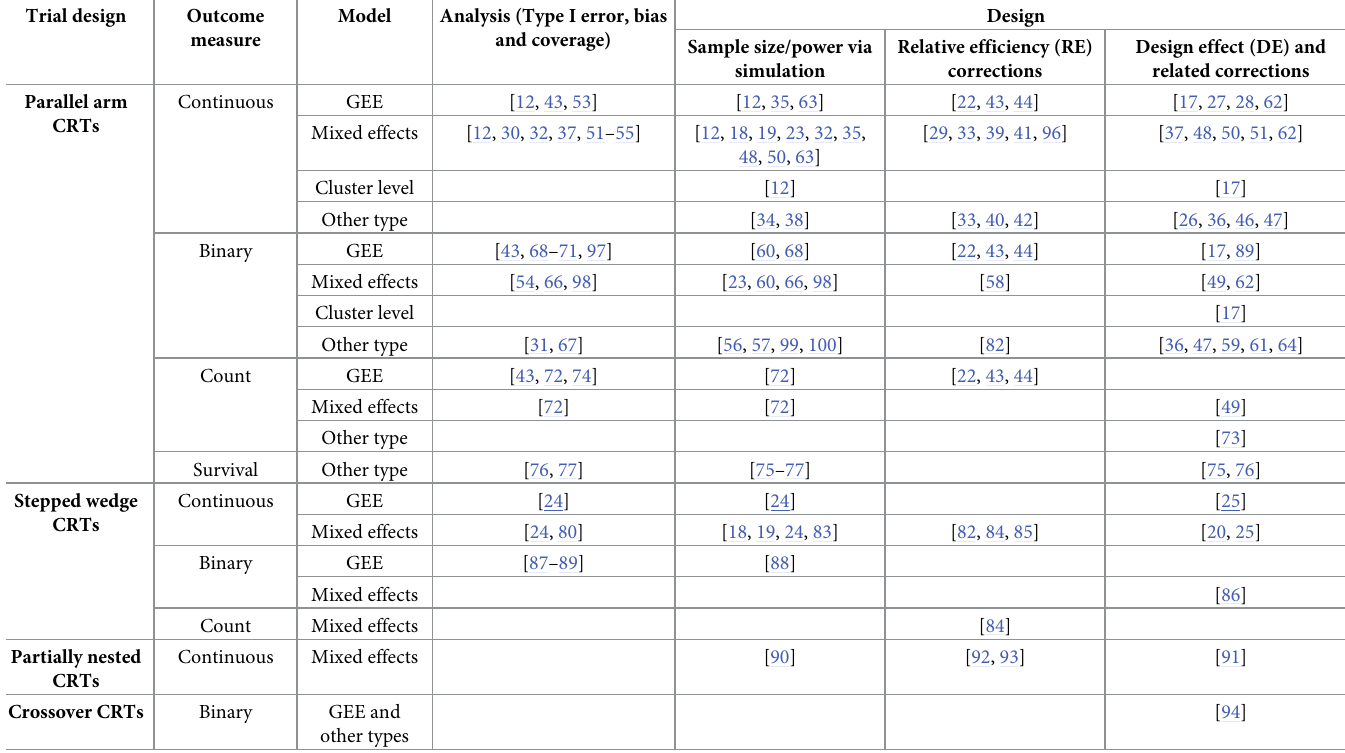
Table 1. Paper information matrix for different types of CRT designs and